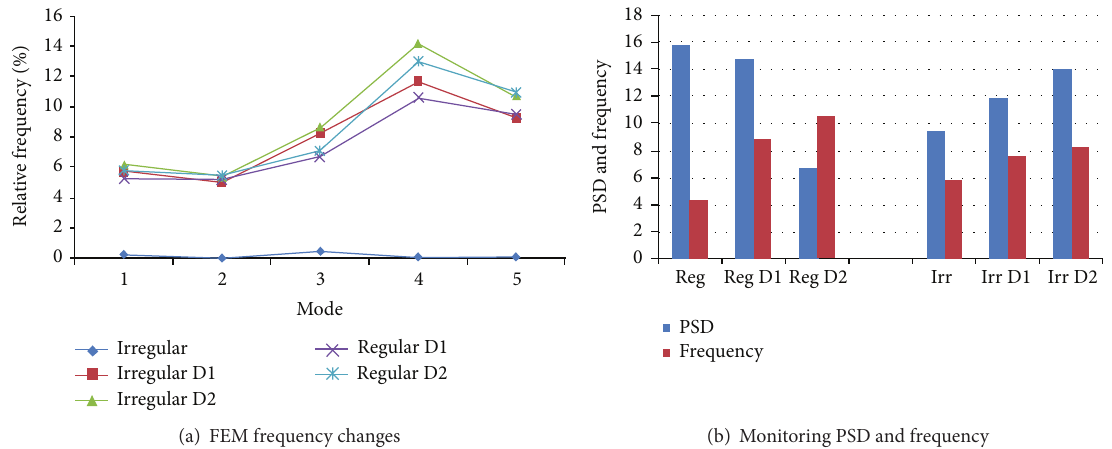
Figure 3: The relative frequency change for the FEM model and PSD for the measurement